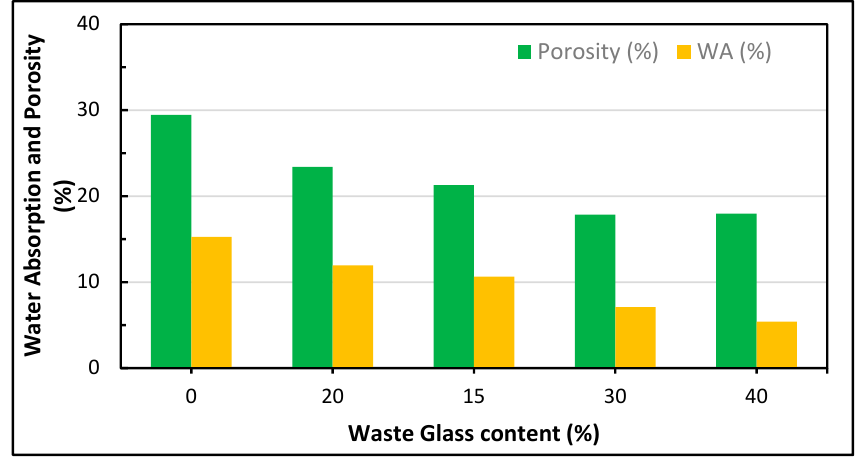
Figure 15. Influence of WG addition on water absorption and porosity [246].